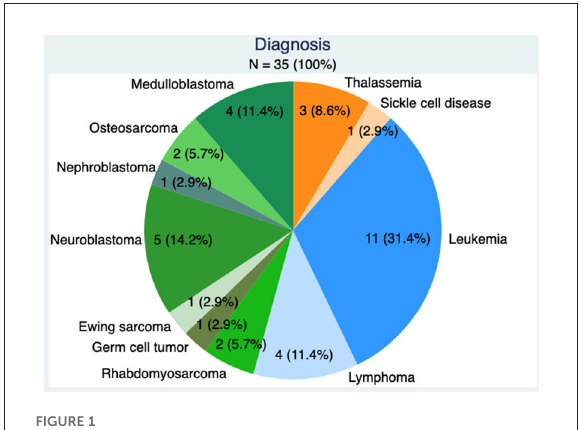
FIGURE1 Diagnosis in the 35 patients, benign conditions in orange, hematological malignancies in blue, and solid tumors in green.